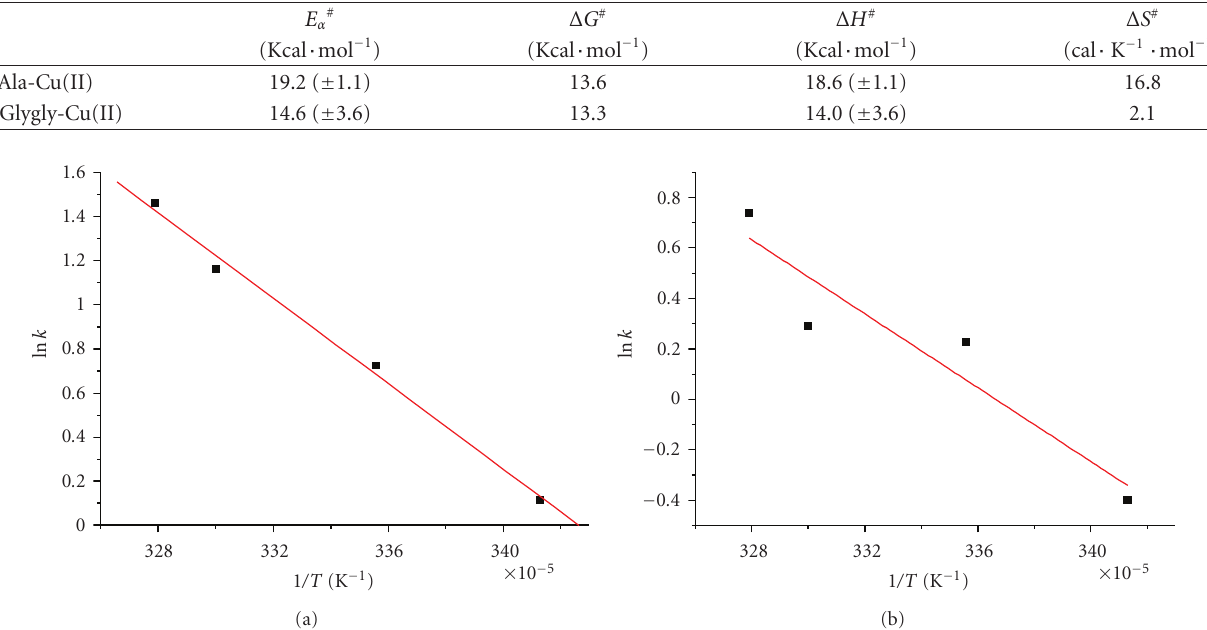
Table 1: Calculated energy parameters for the decomposition of H 2 O 2 from the systems PAla-Cu(II) and PGlygly-Cu(II), respectively.